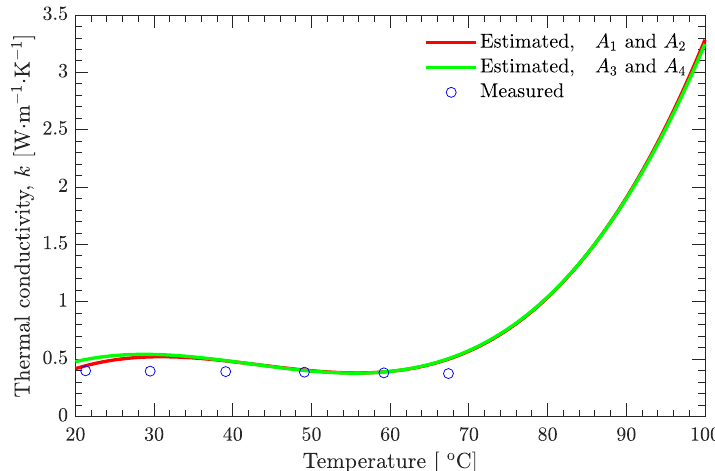
Figure 9. Effect of sensor location errors on the estimated thermal